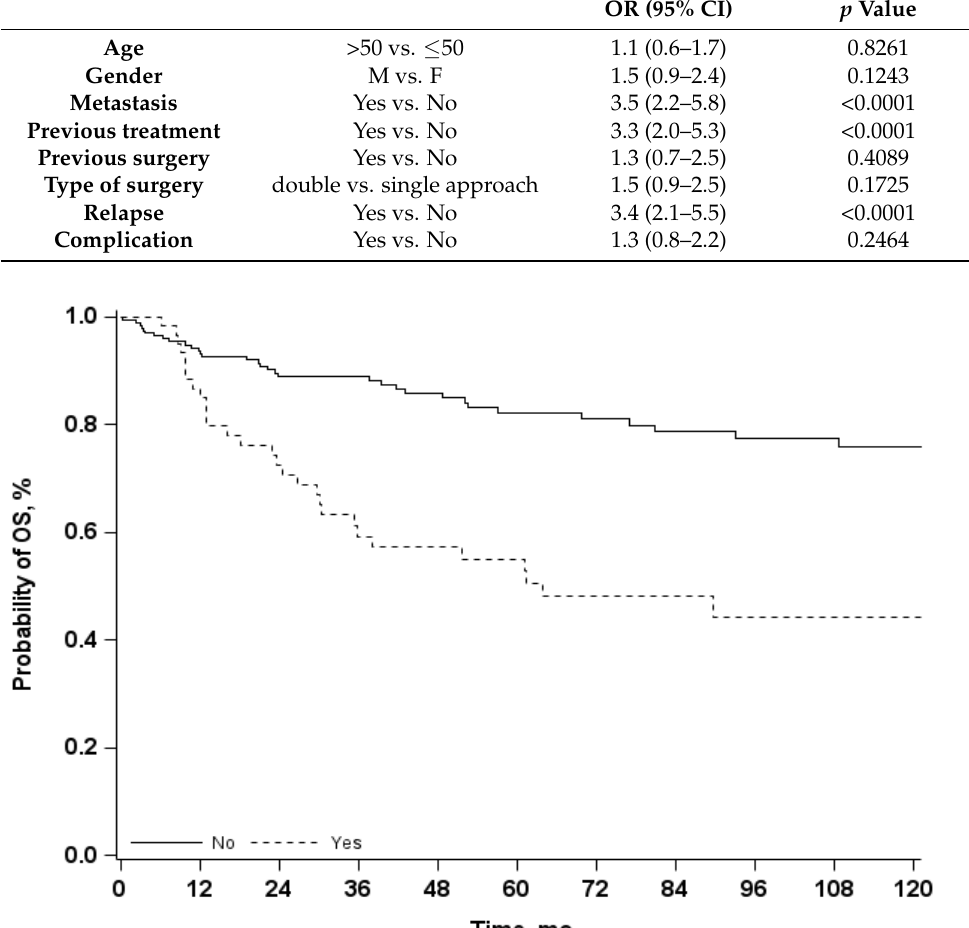
Figure 2. Overall Survival (OS) Kaplan-Meier curves in patients with and without relapse; mo = months.